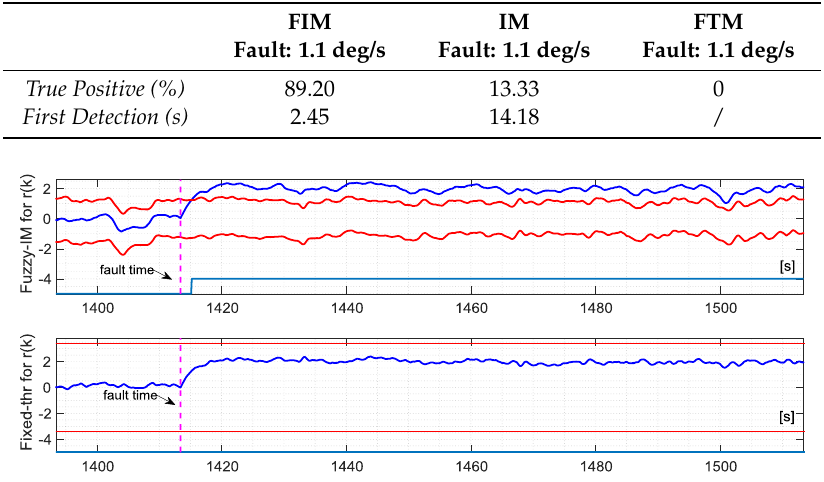
Figure 11. Evolution of the NR residual for the r ( k ) sensor and the corresponding FD intervals as long